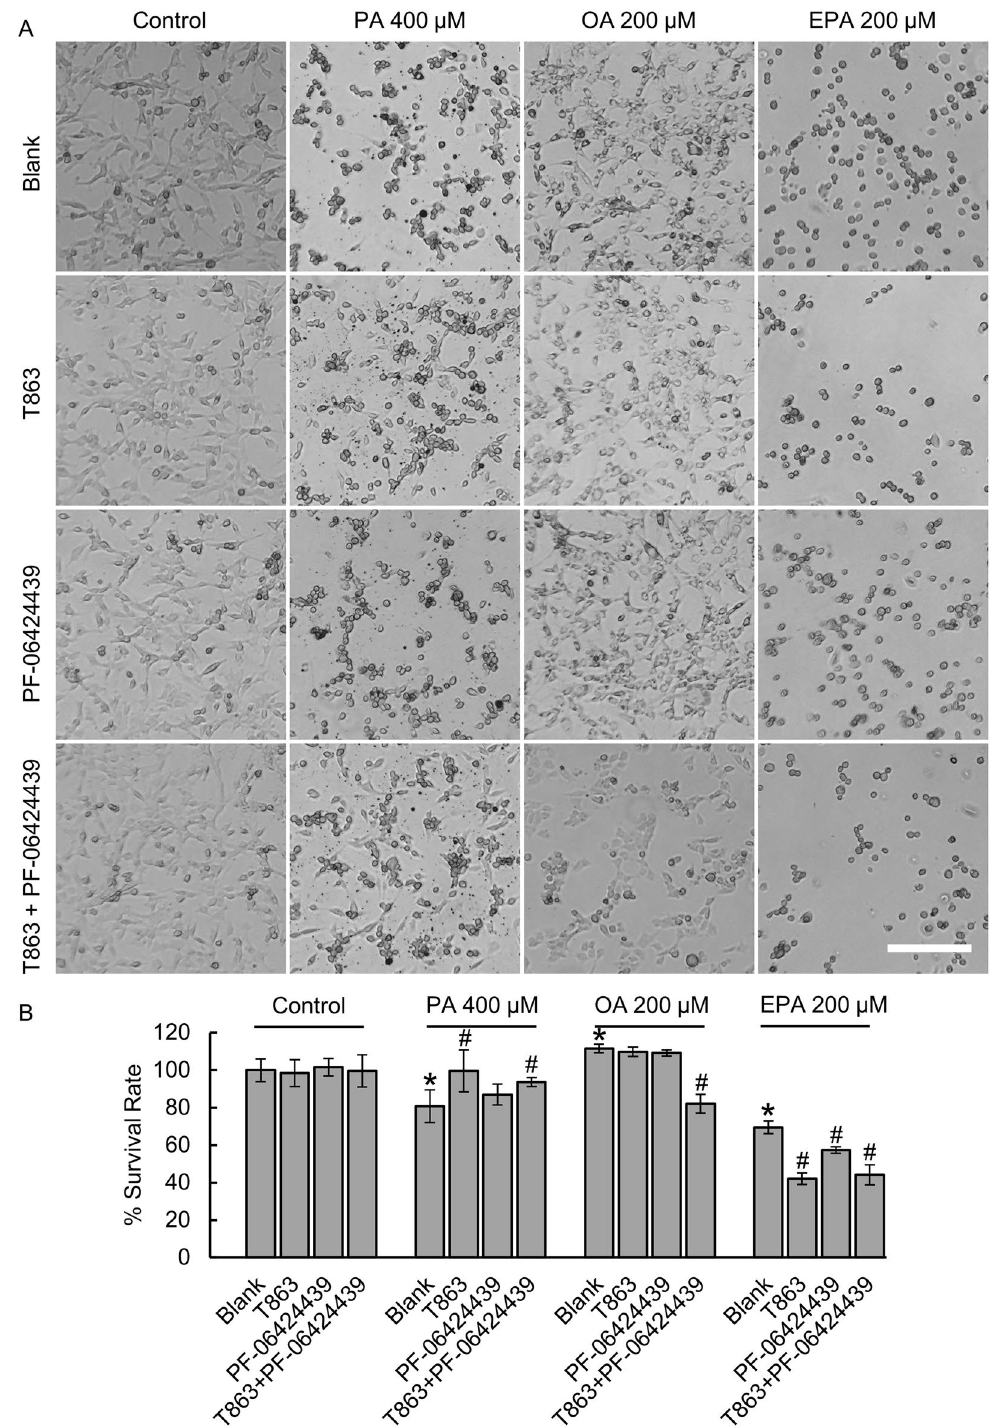
Figure 7. ( A ) Representative images collected using a white-light microscope of U87 glioma cells treated with 400 µM PA, 200 µM OA, or 200 µM EPA, with or without 20 µM T863 or 10 µM PF-06424439 treatments. LDs protected U87 glioma cells in OA- and EPA- but not PA-induced lipotoxicity. Scale bar, 150 µm. ( B ) Quantification of the survival rates of glioma cells under various culture conditions in ( A ). *P < 0.05, the difference is statistically significant from blank in the control group. # P < 0.05, the difference is statistically significant from blank in control for all PA-, OA-, and EPA-treated